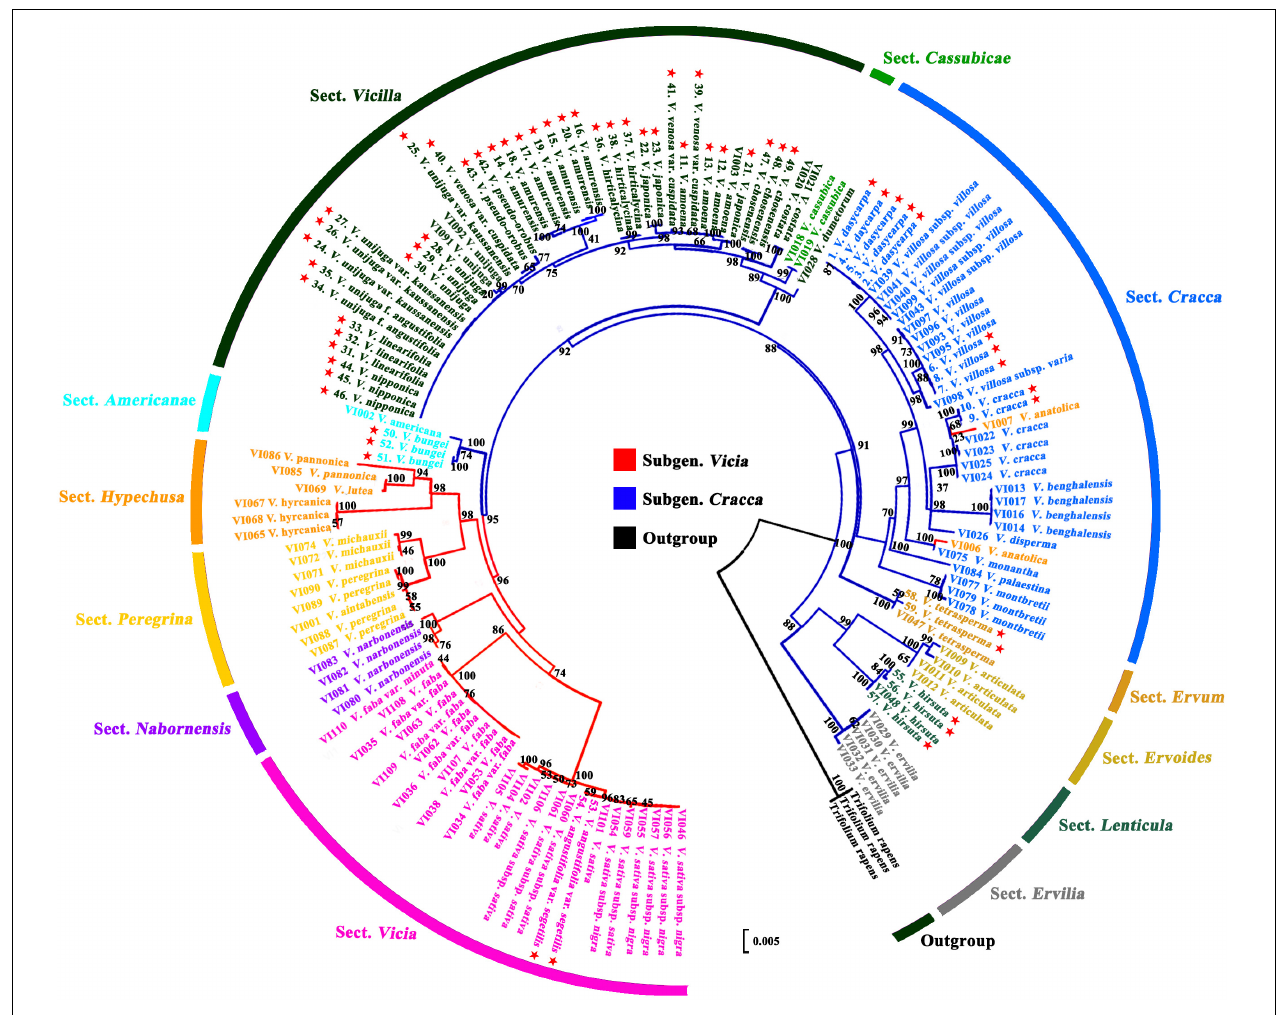
FIGURE 3 | Phylogenetic analysis of Vicia species based on the nucleotide sequences the combined ITS2 + matK + rbcL regions. (cid:70) Collected accessions of native Vicia species in this